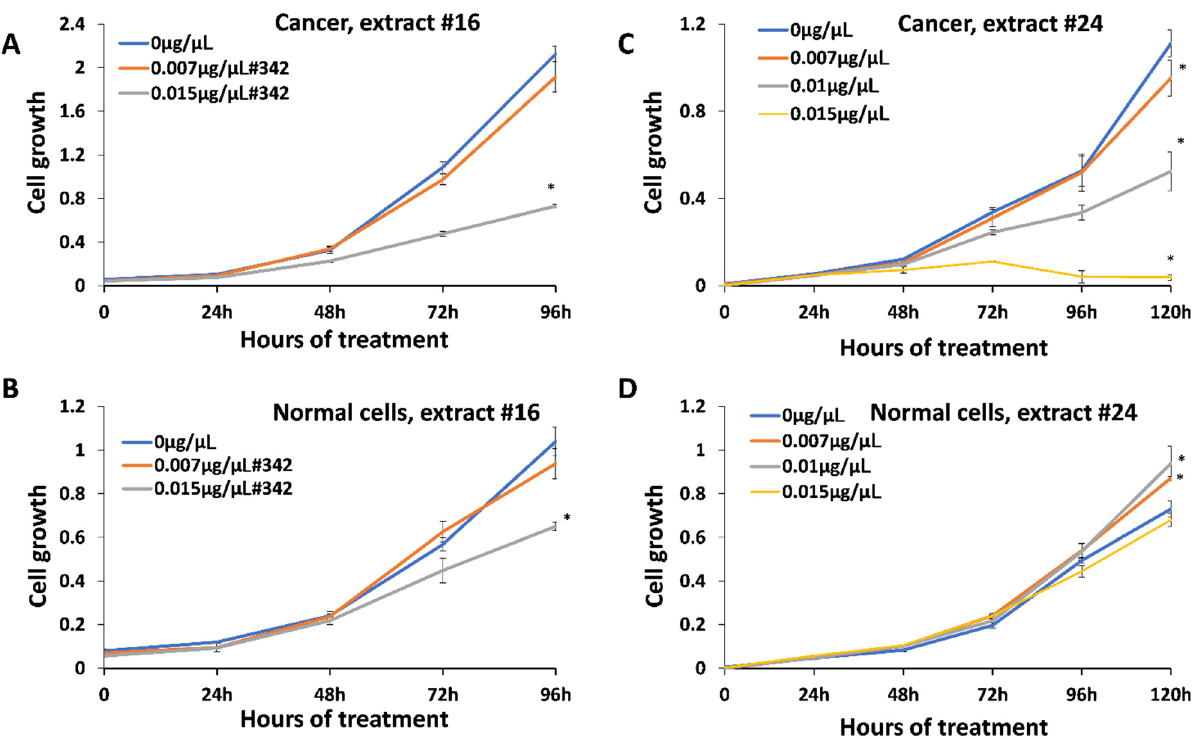
Figure 2. Inhibition of growth of breast cancer cell line HCC1806 and normal cell line BJ-5ta. ( A )—growth curve of HCC1806 cells in response to extract #16; ( B )—growth curve of BJ-5ta cells in response to extract #16; ( C )—growth curve of HCC1806 cells in response to extract #24; ( D )—growth curve of BJ-5ta cells in response to extract #24. Cells were treated with 0, 0.007 and 0.015 ug/uL of the above-mentioned extracts for various periods of time, from 0 to 120 h. MTT assay was performed and data were expressed as an average (from 3 independent replicates) with SD. Asterisks indicate significant ( p < 0.05) difference from control (0 ug/uL).